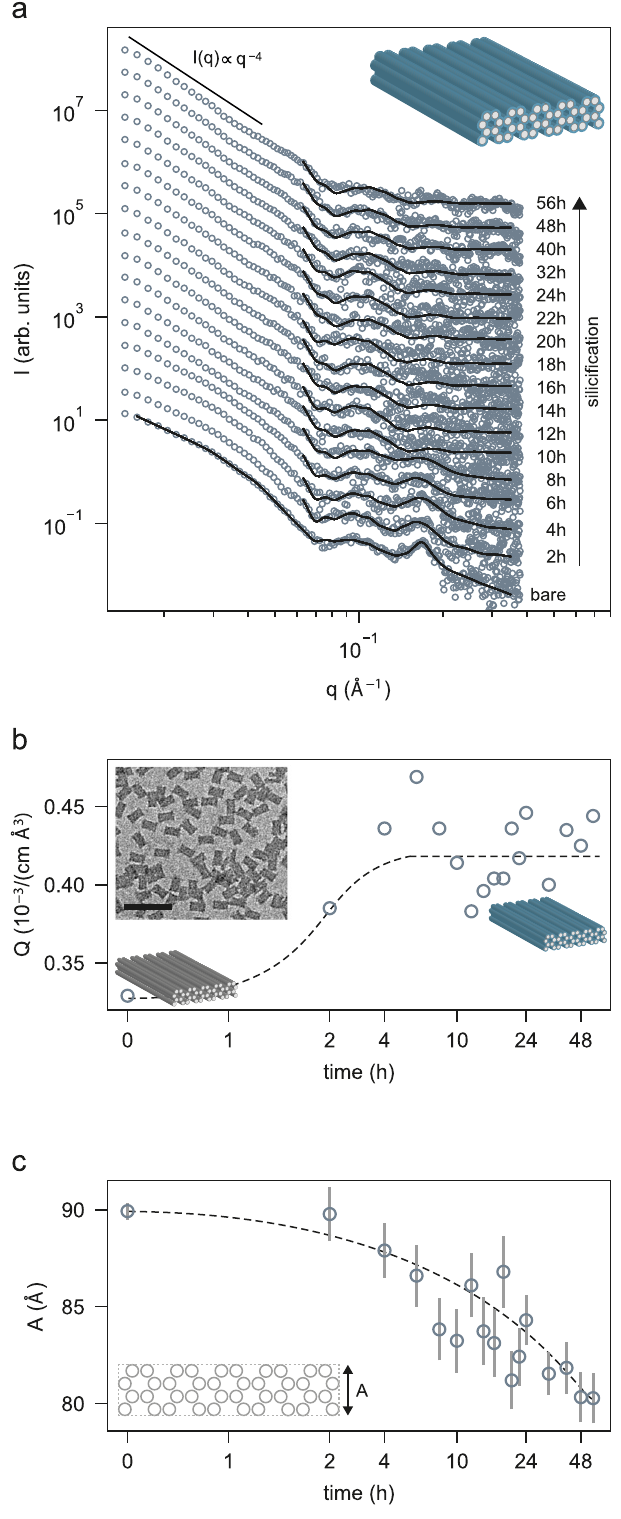
Fig. 4 | Silici fi cationofthe4-LBcuboids analyzed by SAXS. a SAXS intensities of 4-LBs, before and during silici fi cation, with best fi t of a cuboid model, and Lor- entzian peaks accounting for the honeycomb lattice structure. Data is scaled for clarity. b Silica growth time dependence of the model-free Porod invariant Q extracted from a and a TEM micrograph of 4-LB @SiO2. Scale bars: 200 nm. c Heights A of the overall cuboid-shaped 4-LB as function of silica growth time. Schematic 4-LB cuboid shape with honeycomb lattice structure and front view are shown in the insets. Dashed lines serve as guide to the eye. Error bars indicate standard deviation sigma due to modelling of the x-ray data for each time